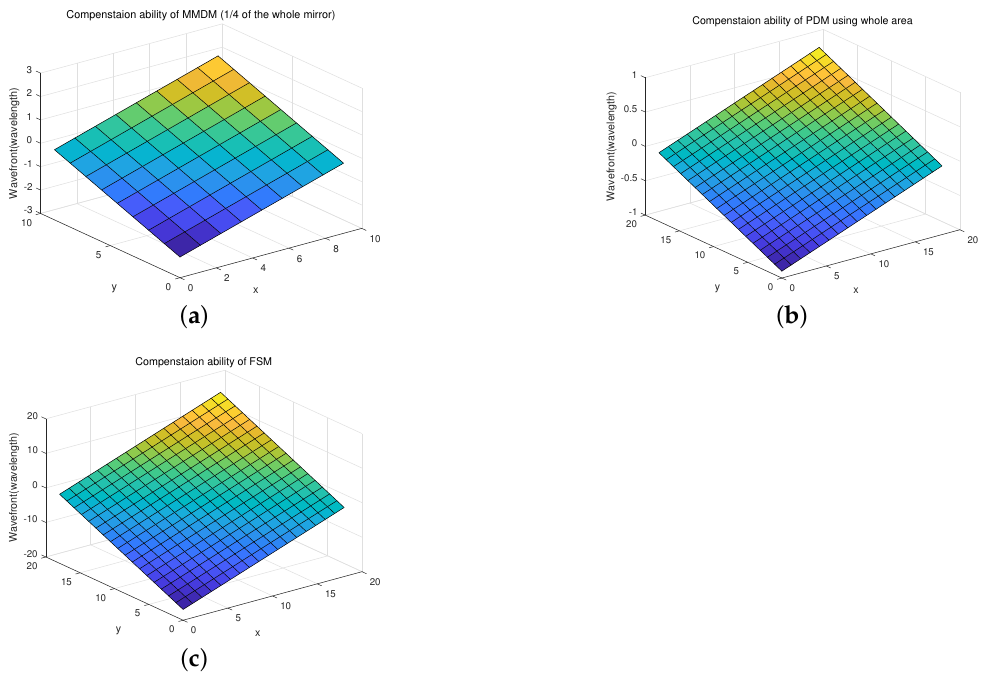
Figure 3. ( a ) Theoretical compensation ability of 1 compensation ability of PDM for tilts aberrations. ( c ) Theoretical compensation ability of FSM for tilts